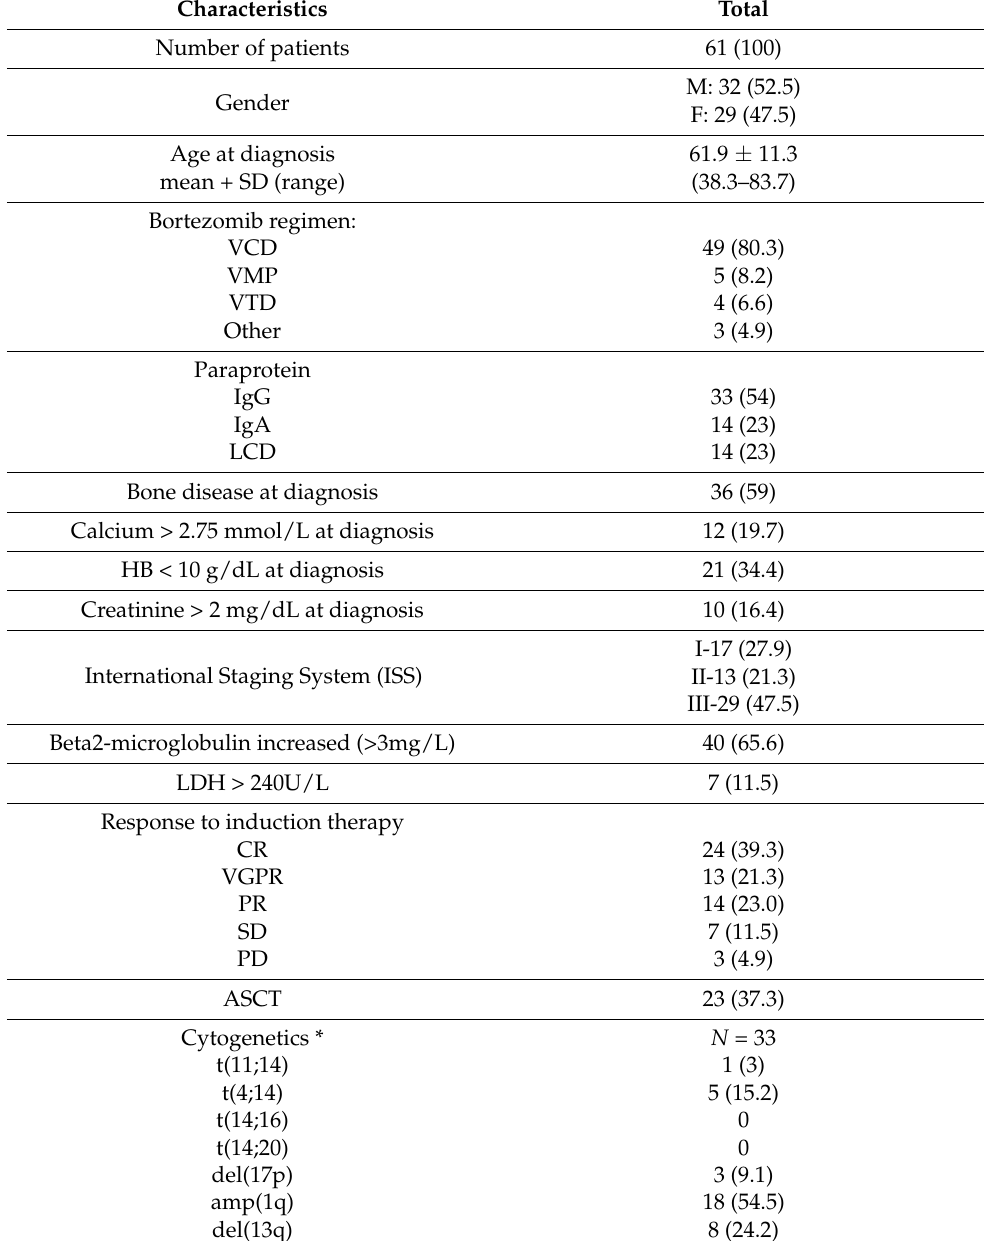
Table 1. The characteristics of the study group, comprising 61 patients receiving bortezomib-based therapy. Unless otherwise specified, all data are presented as frequency and percentage